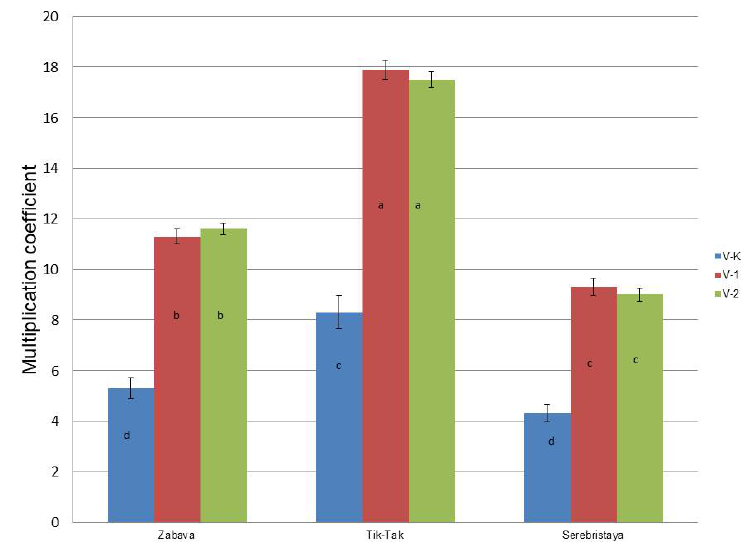
Figure 1. Significant effects of media on the multiplication coefficient in developing peppermint explants. Different letters indicate significant differences between media according to Tukey’s test ( p ≤ 0.05).; bars represent standard deviations.